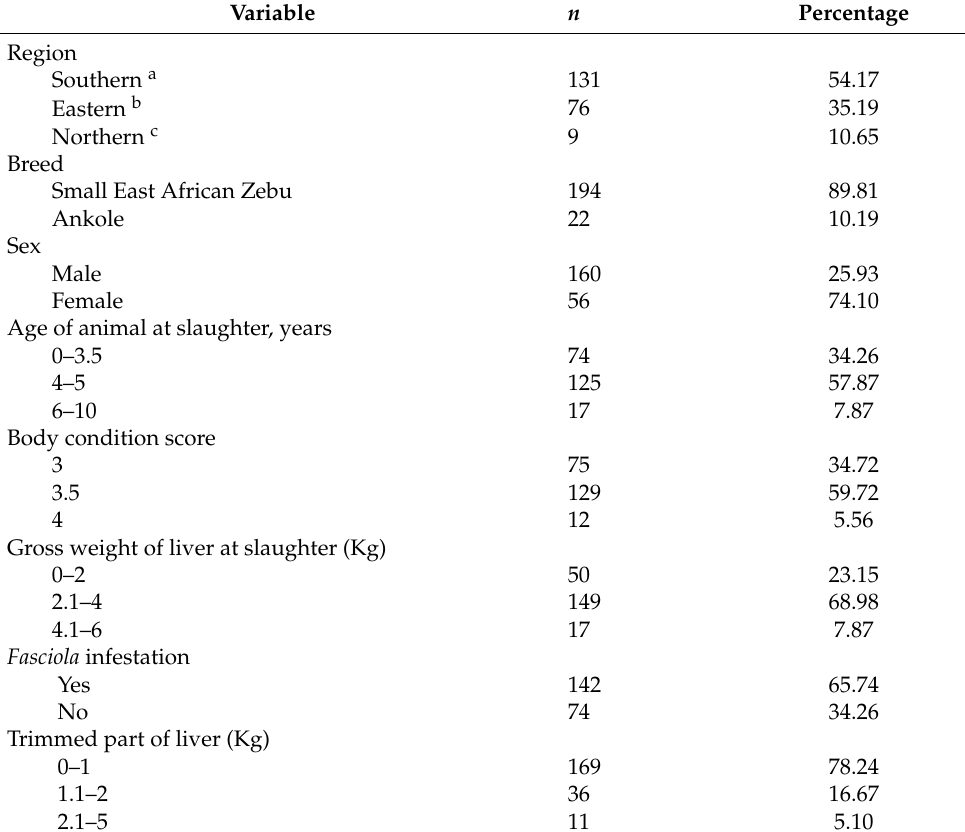
Figure 1. Sources of animals slaughtered at Lira Municipal abattoir in Uganda, Africa. The abattoir location is marked by the red dot. Sampling locations were reclassified into three regions: Southern (Achwa, Amach, Bala, Boroboro), Eastern (Apala, Barr, Otuke), and Northern regions (Agweng, Alito, Barlonyo, Mocwari, Ngetta). Table 1. Summary of distribution and characteristics of slaughter cattle ( n = 214) at Lira Municipal abattoir examined for Fasciola spp. infestation. Physical characteristics were determined during antemortem examination, while liver samples were examined post-slaughter.